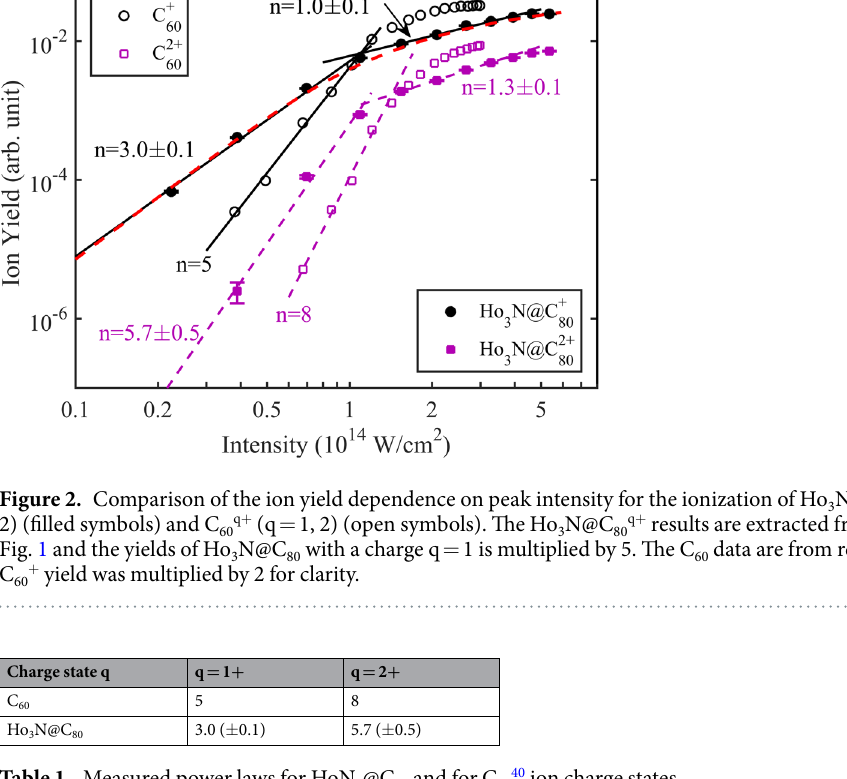
Table 1. Measured power laws for HoN 3 @C 80 and for C 6040 ion charge